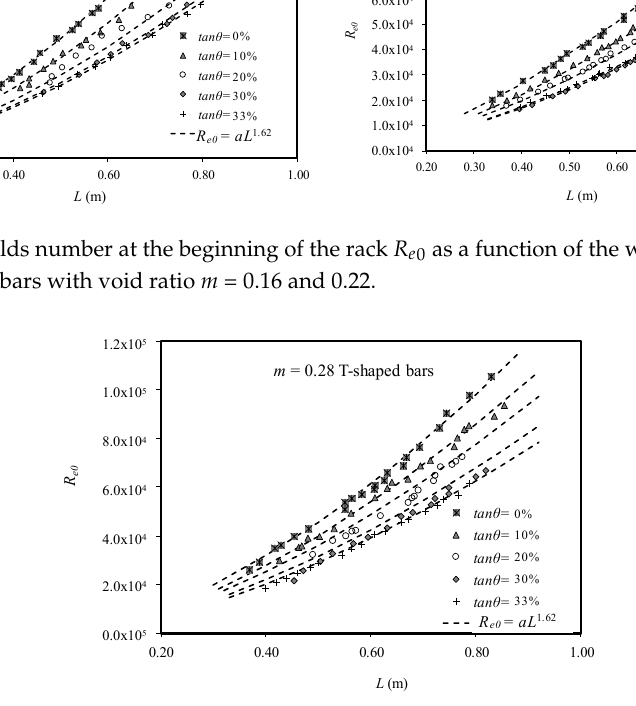
Figure 17. Reynolds number at the beginning of the rack R e 0 as a function of the wetted rack length L , for T-shaped flat bars with void ratio m = 0.28.